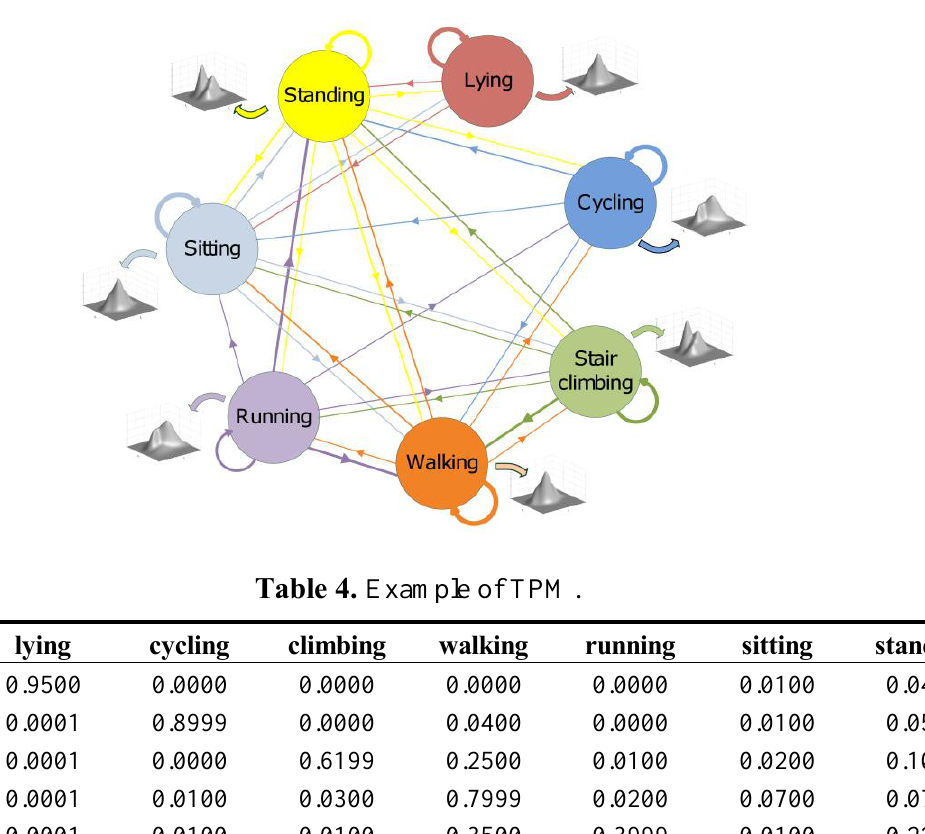
Figure 5. Sequential classification through an HMM-based classifier.